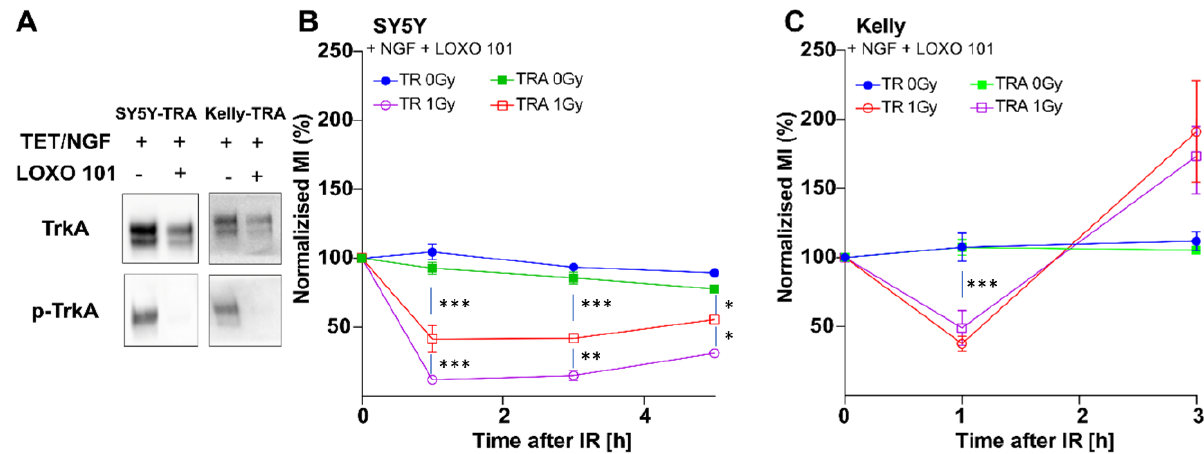
Figure 3. TrkA/NTRK1 inhibition abrogates the TrkA-mediated effect on the G2 checkpoint upon irradiation in SY5Y and Kelly cells ( A ) Expression and activation of TrkA/NTRK1 in SY5Y-TRA and Kelly-TRA cells with and without LOXO 101 treatment. Original Western Blots have been included as Supplementary Figure S5. Activation of TrkA/NTRK1 in SY5Y cells ( B ) or Kelly cells ( C ) was achieved by addition of NGF and cells were treated with the Trk-Inhibitor LOXO 101 prior to IR. MI values were normalized to the respective unirradiated controls. Asterisks indicate significant differences between experimental groups as indicated (*** = p < 0.001, ** = p < 0.01, * = p < 0.05). Error bars show the SEM from 3–5 independent experiments.